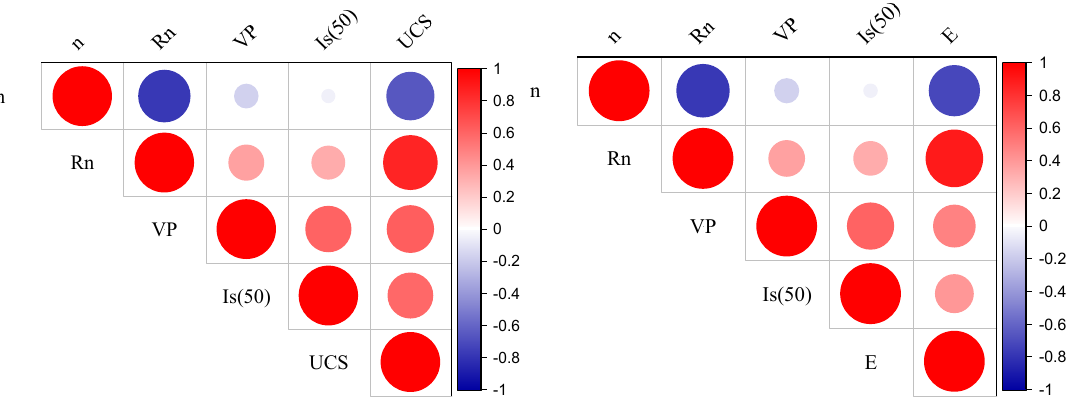
Figure 4. Distribution of the database.